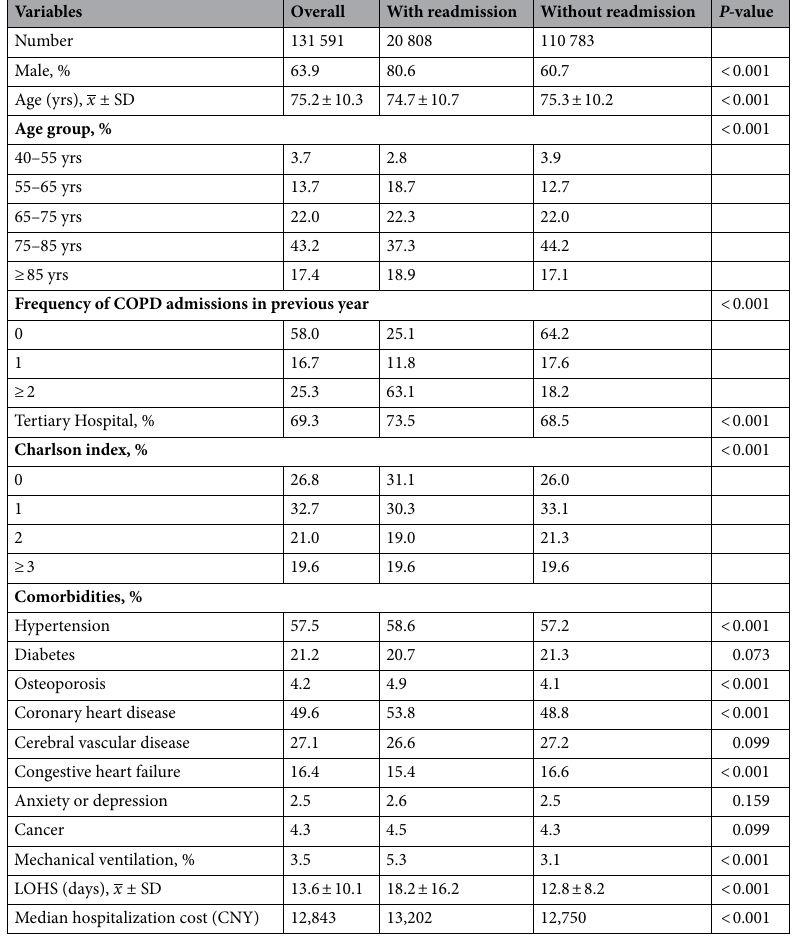
Table 2. Comparison of characteristics at index admission between those with and without 30-day COPD readmission (n = 131 591). The unit of analysis was hospitalization instead of patient. All costs were adjusted for the increment of inflation. LOHS length of hospital stay, CNY Chinese